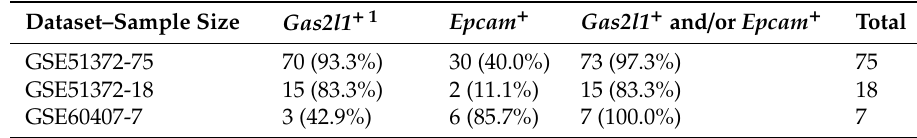
Table 1. Expression of GAS2L1 in CTC